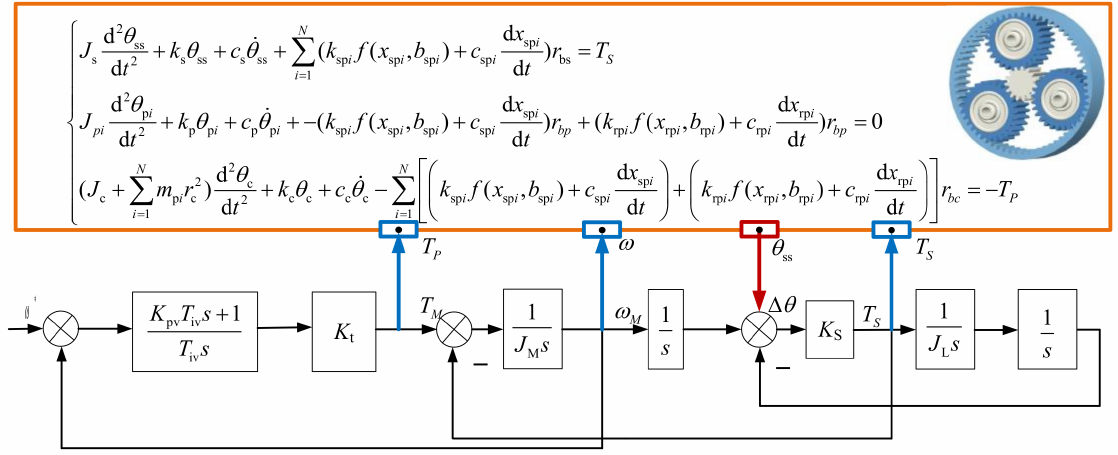
Figure 5. The control block diagram of the flexible joint servo system.